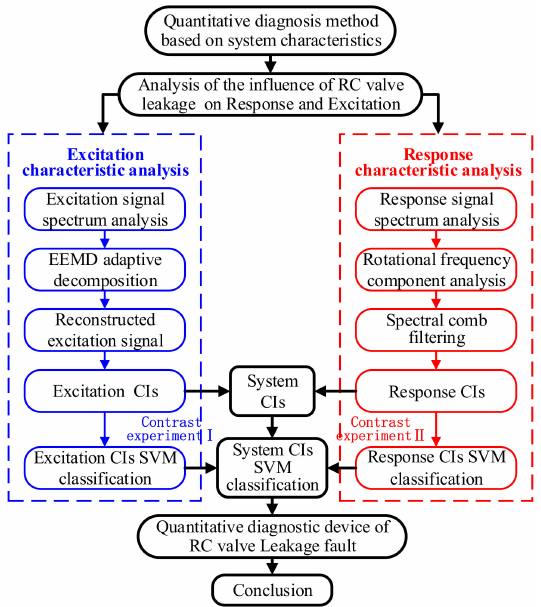
Figure 1. Quantitative diagnosis method of reciprocating compressors (RC) valve failure based on system characteristics.